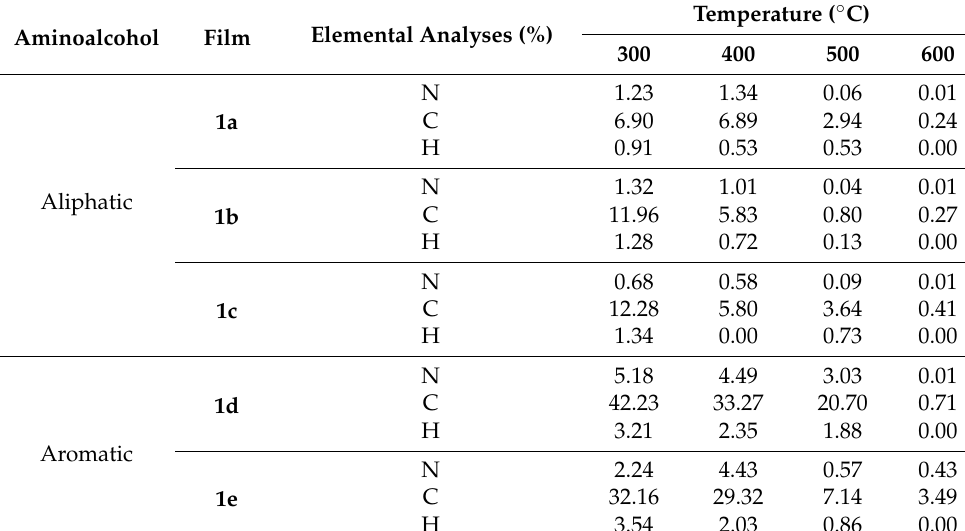
Figure 3. IR spectra of films 1a–1e at different annealing temperatures. Table 1. Summary of the results obtained from the elemental analyses of 1a – 1e films after heating at different temperatures (T) (the standard deviation parameter of data is ±